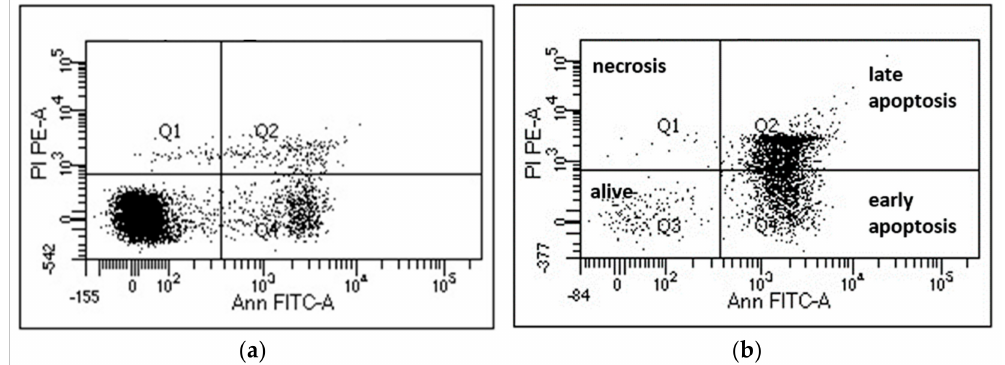
Figure 3. Flow cytometry analysis of NCI-H929 cells. ( a ) untreated control cells and ( b ) cells treated with 50 µ M of compound 3 for 24 h. After treatment, cells were stained with AnnexinV-FITC (Ann FITC-A) and propidium iodide (PI PE-A). The percentage of cells alive (no staining) were retrieved from values in